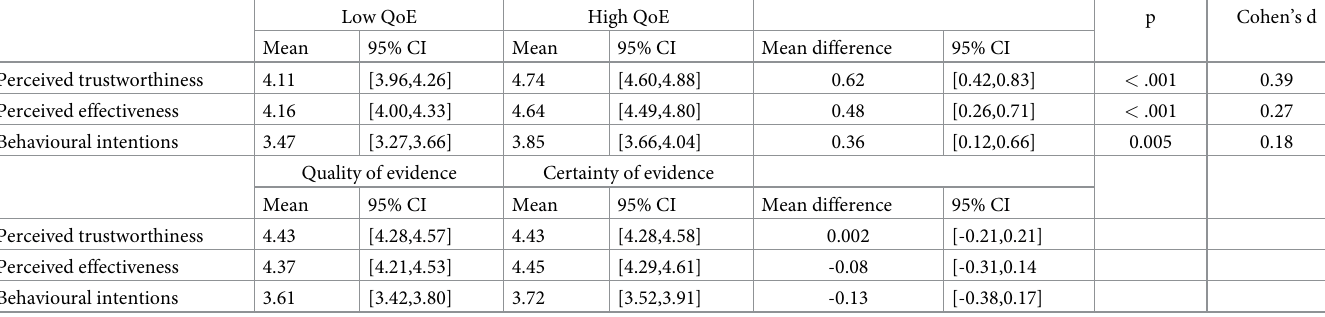
Table 4. Post hoc results for main effects of quality of evidence level and wording (Experiment